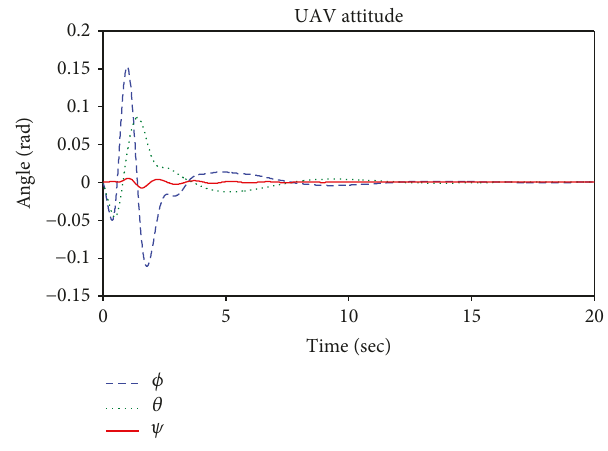
Figure 18: Attitude of the UAV.